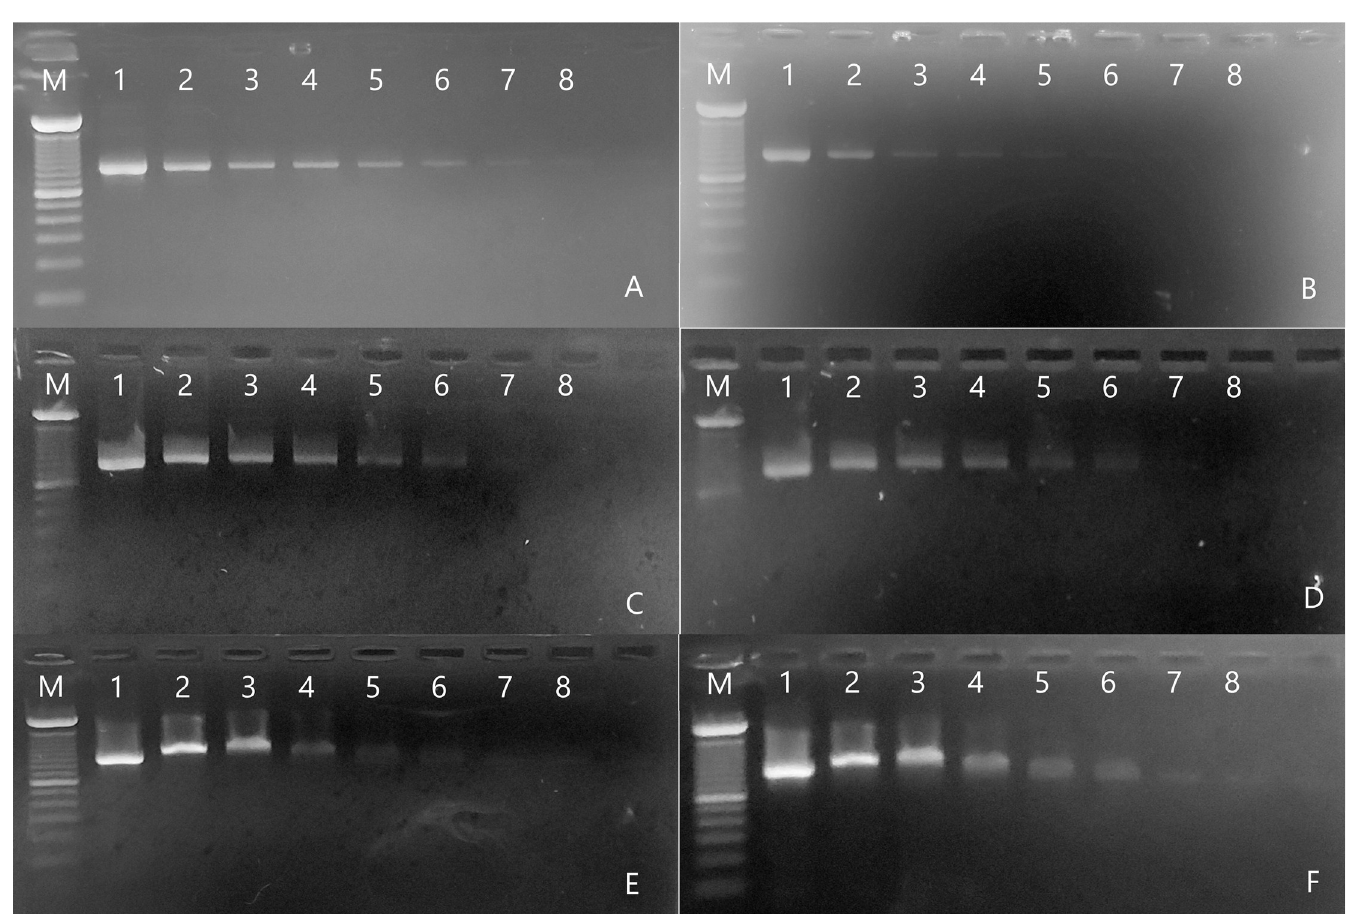
Fig 6. Agarose gel electrophoresis images from three different dyes. Ethidium bromide (A, B); GelRed (C, D); and SYBR Green (E, F). Photos obtained from the use of a conventional UV-transilluminator are on the left panel (A, C, and E). Images captured from the proposed device are on the right panel (B, D, and F). All photos underwent the same image treatment in the ImageJ software [21] so that there was no advantage for comparative analysis. Samples in the gel lanes are serial dilutions of the PCR final product (see Material and Methods). M–HighRanger 1 Kb DNA Ladder molecular marker (Norgen Biotek Corporation); DNA quantities: 1–228 ng; 2–114 ng; 3–57 ng; 4–28.5 ng; 5–14.28 ng; 6–7.14 ng; 7–3.54 ng; 8–1.8